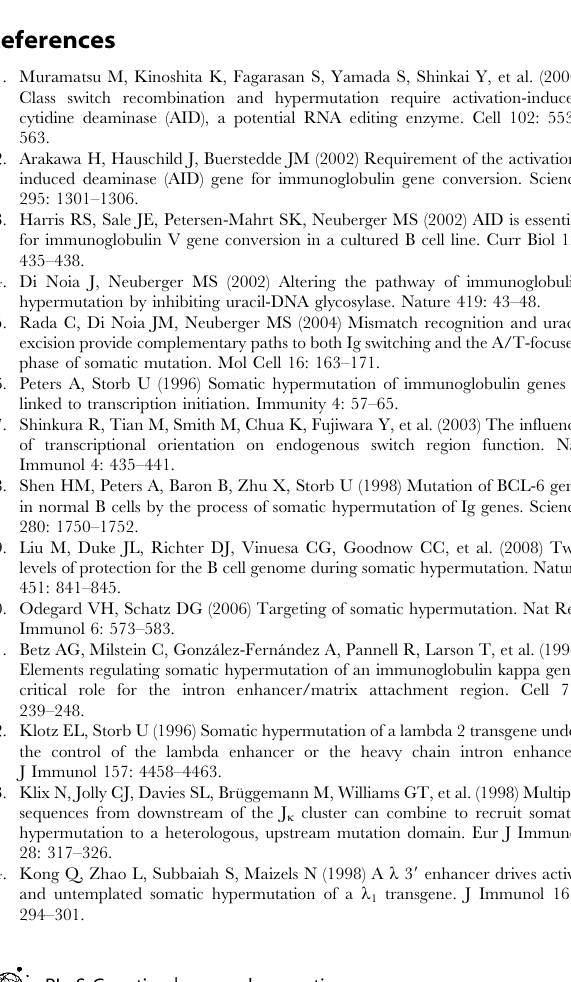
Figure S2 Comparison of GFP gene expression levels analyzed by semi-quantitative RT-PCR of primary transfectants belonging to the stepwise deletions series of the ‘ W ’ fragment. Table S1 Green fluorescence decrease in individual primary transfectants. (A) GFP2 reporter in the vicinity of the IgL locus. (B) GFP2 reporter in non-Ig loci.